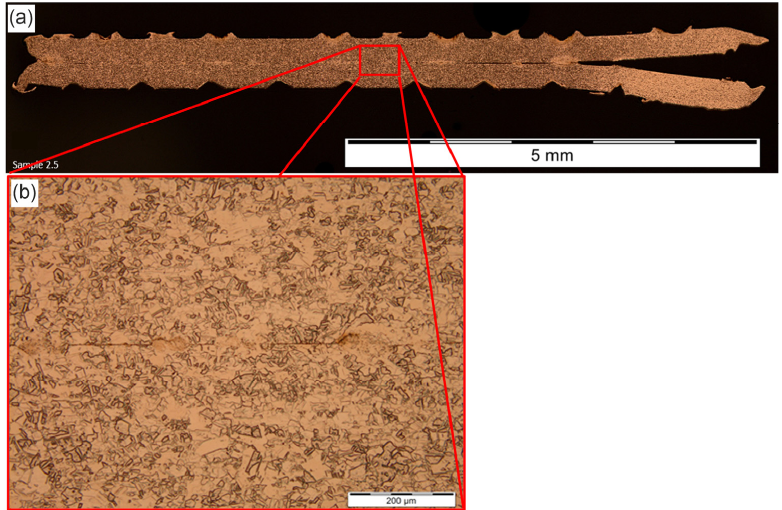
Figure 7. Metallographic images of: ( a ) etched Cu—Cu weld sample (×50); ( b ) detail images of the weld interface (×200).